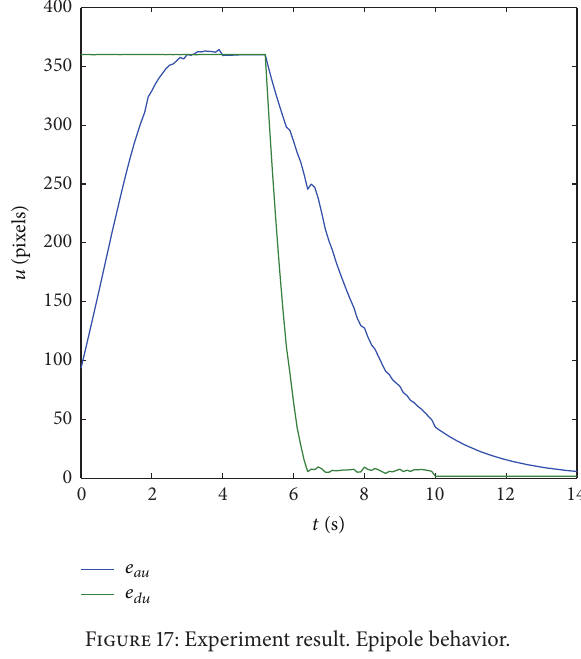
Figure 17: Experiment result. Epipole behavior.